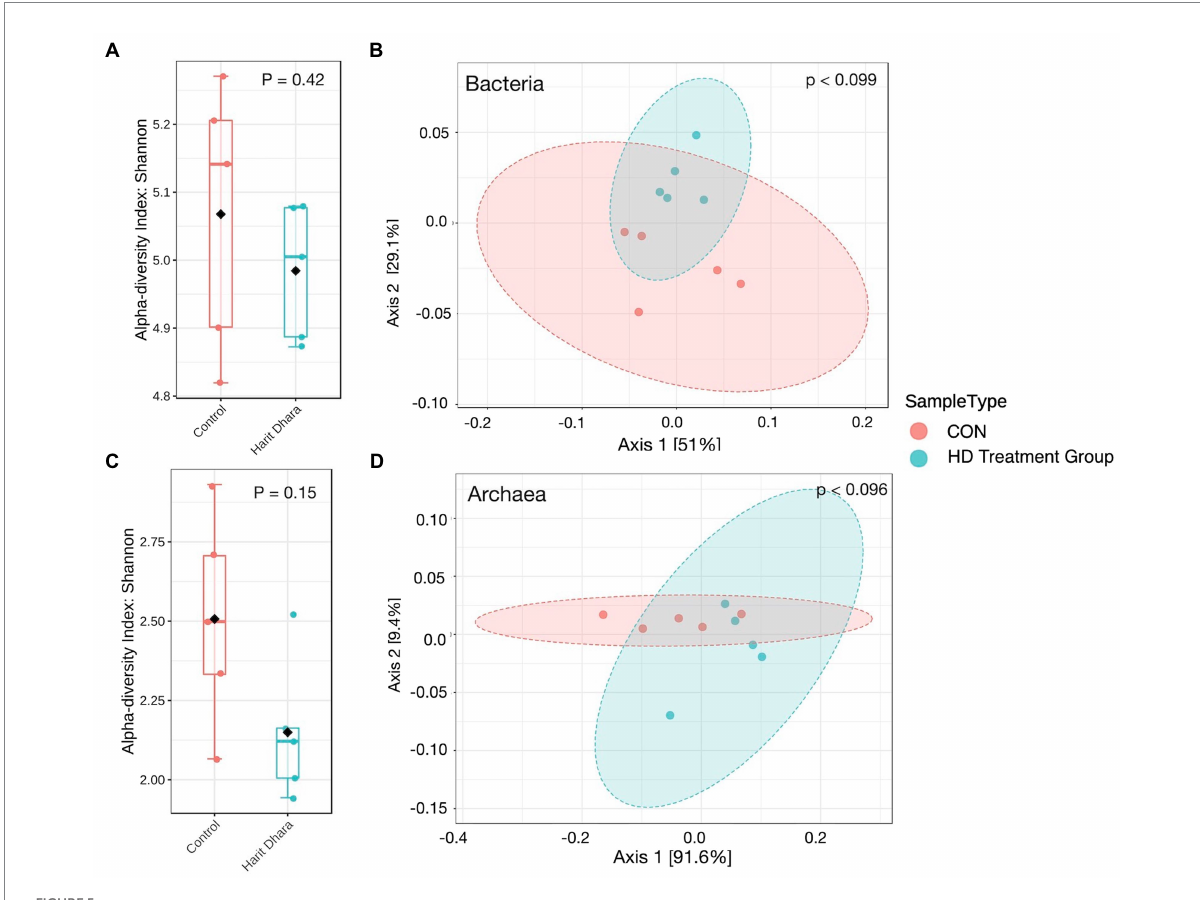
FIGURE 5 Alpha and beta diversity plots of bacteria (A,B) and archaea (C,D)